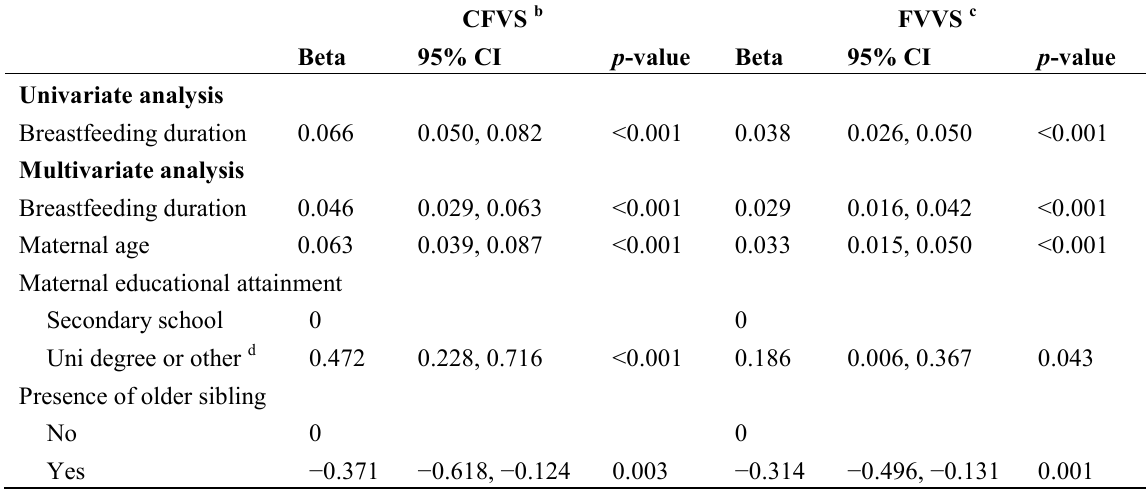
Table 3. Association of breastfeeding duration a with Core Food Variety Score (CFVS) and Fruit and Vegetable Variety Score (FVVS) at 2-years of